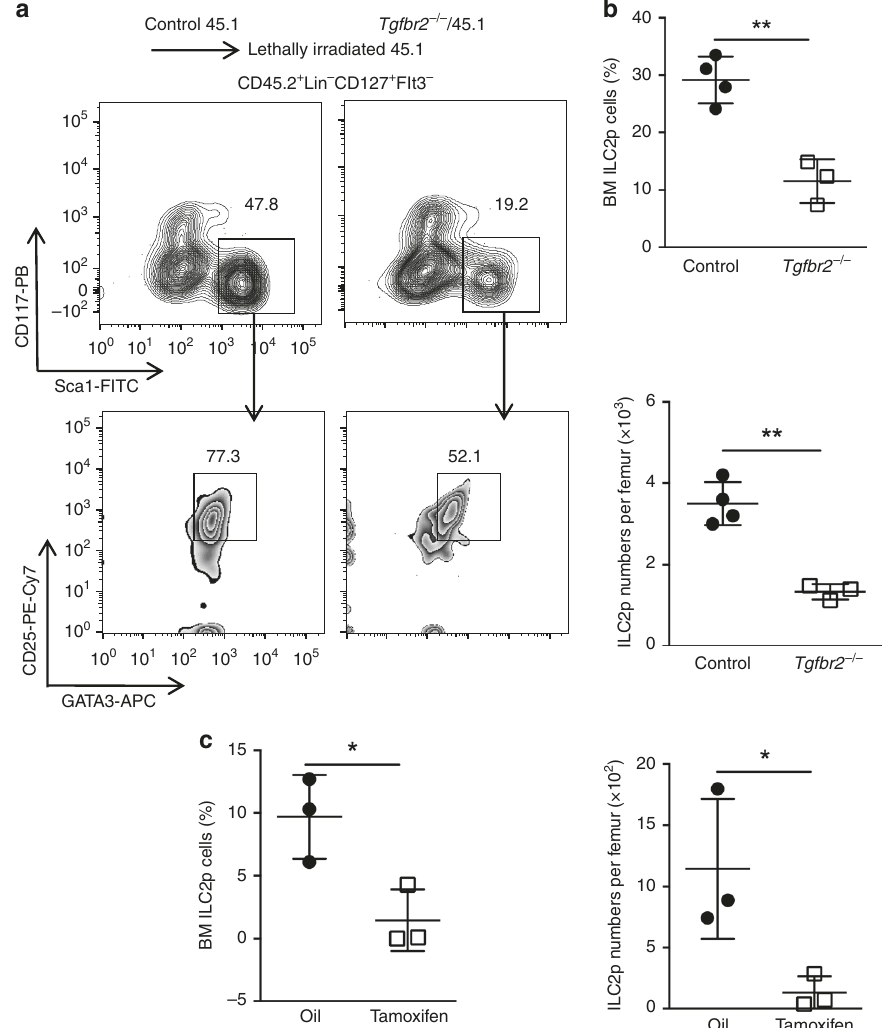
Fig. 2 T β R2 deletion decreases ILC2 lineage-committed precursor (ILC2p) in the bone marrow. a Representative FACS plots of CD117 − Sca1 + CD25 + GATA3 + ILC2p gating on CD45.2 + Lin − CD127 + Flt3 − cells in the BM of Control/CD45.1 and Tgfbr2 − / − /CD45.1 BM chimeras. b Summary of the frequency and total numbers of ILC2p cells in the BM of Control/CD45.1 and Tgfbr2 − / − /CD45.1 BM chimeras ( n = 3 – 4 mice per group). c Summary of the frequency and total numbers of ILC2p cells in the BM of Tgfbr2 f/f ER-Cre + ILC progenitor/CD45.1 BM chimeras post-treated with tamoxifen or oil ( n = 3 – 4 mice per group). Numbers indicate percentages of cells in the indicated gates. All data are representative of two independent experiments. Data are shown as mean ± SD; * p < 0.05, ** p < 0.01 (Student ’ s t